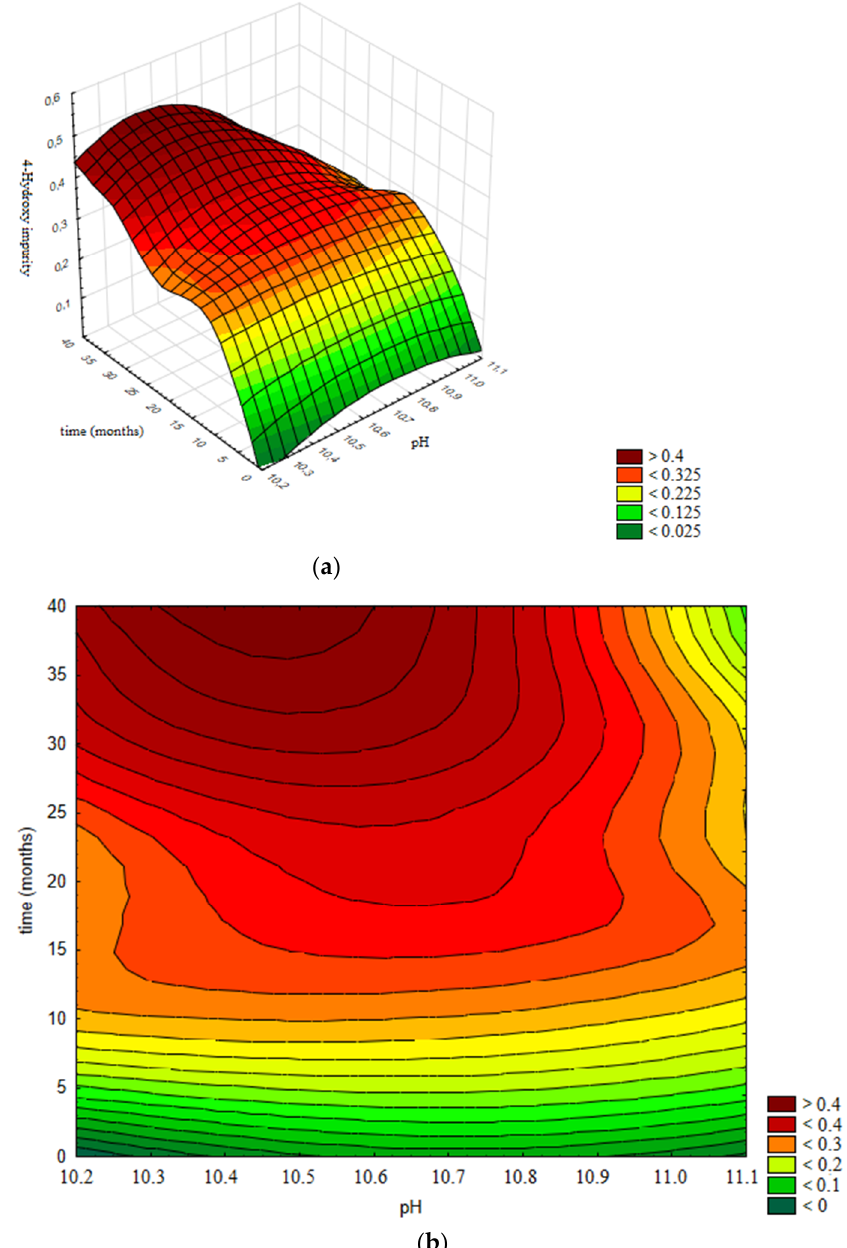
Figure 16. Influence of pH value and time on the assay of 4-Hydroxy impurity: ( a ) Response surface; ( b ) Contour plot.